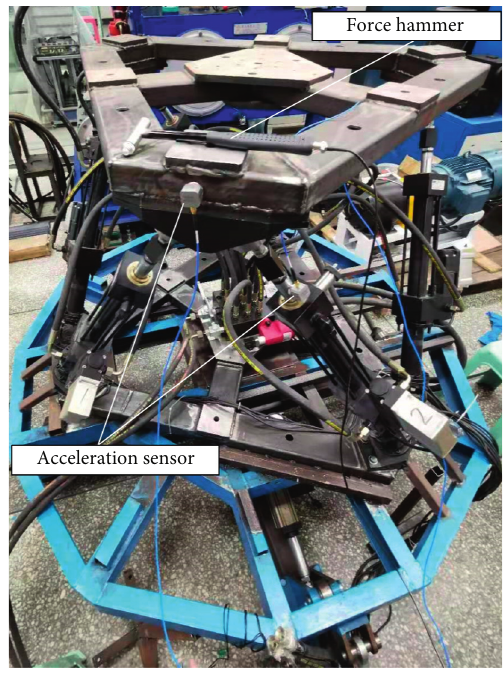
Figure 15: Test platform for the modal test.